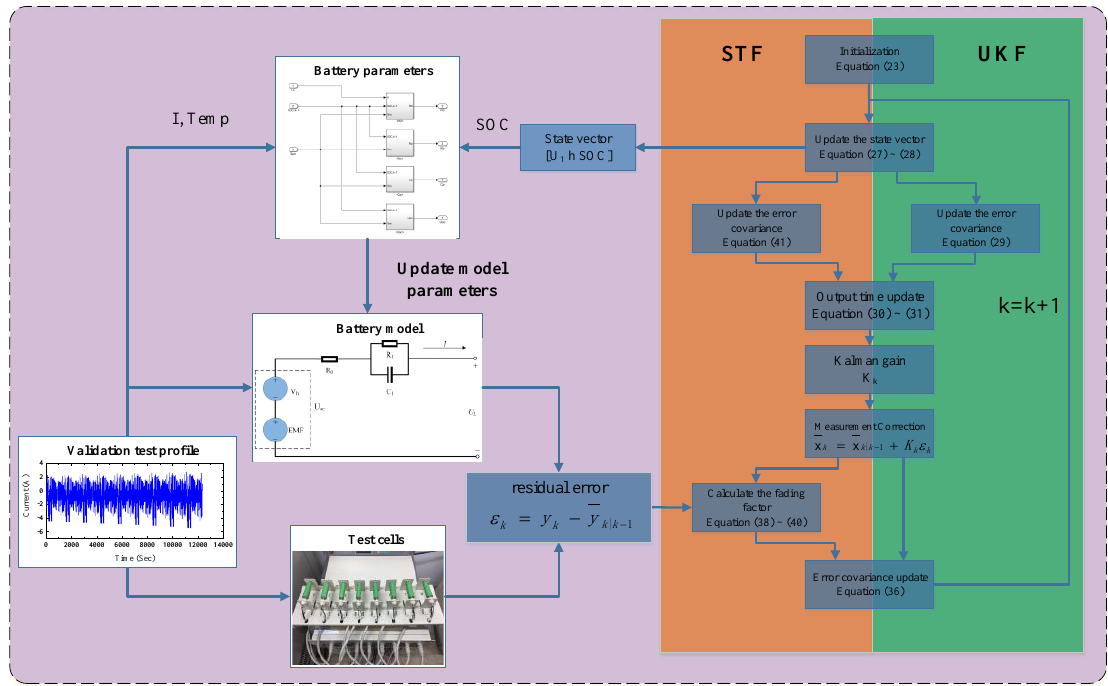
Figure 11. Block diagram of the proposed battery SOC observers.